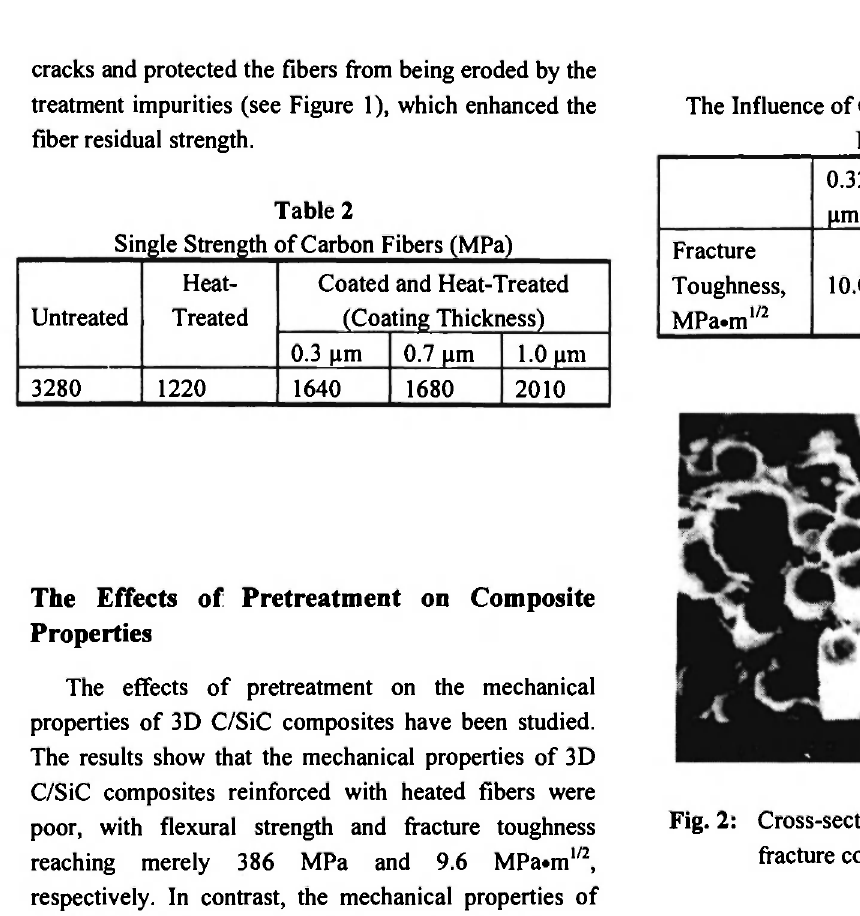
Fig. 2: Cross-section microstructure (SEM) of the fracture composites.